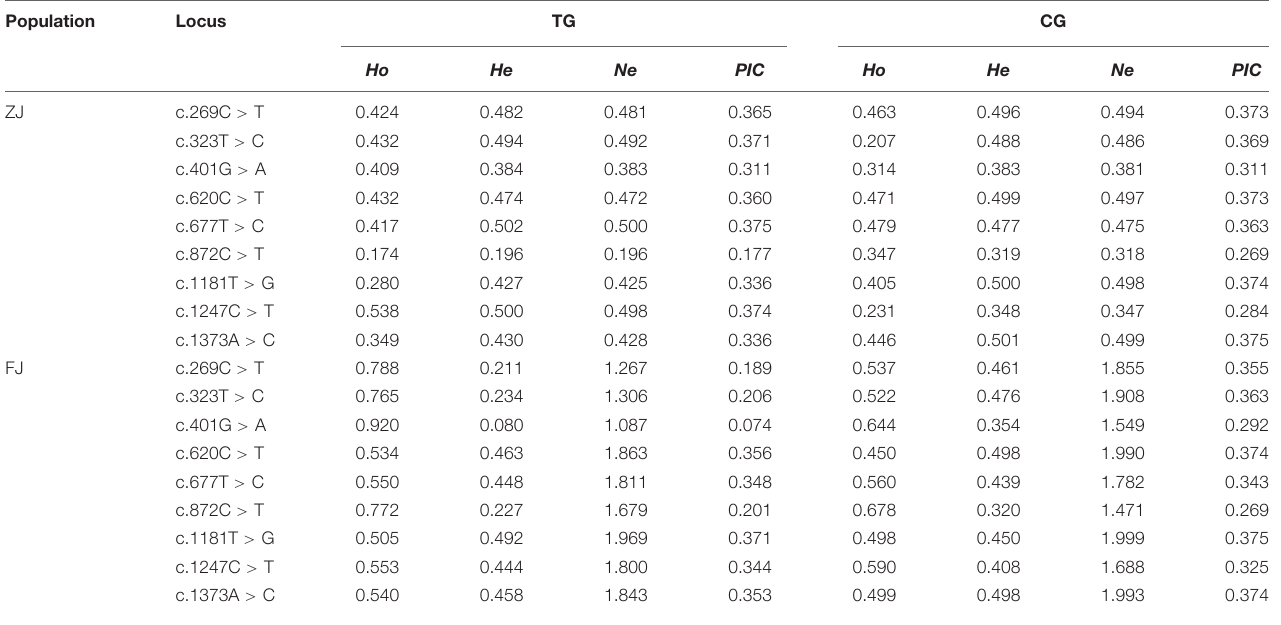
TABLE 3 | Population genetic parameters of variable loci in Sc-GDH .